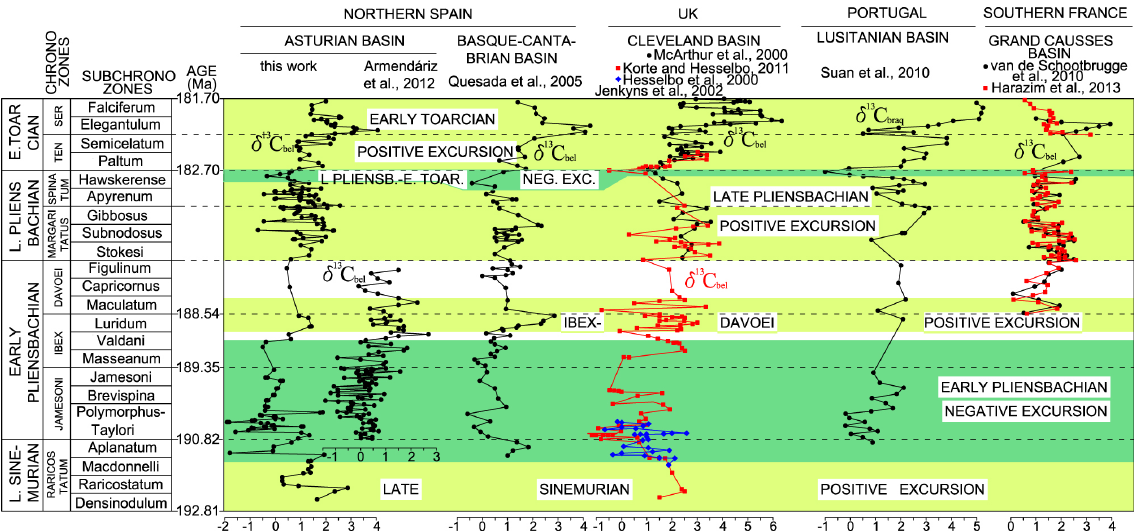
Figure 6. Correlation chart of the belemnite calcite-based δ 13 C sketched curves across Western Europe. The earliest isotopic event is the Late Sinemurian δ 13 C positive excursion, followed by the Early Pliensbachian negative excursion and the Ibex–Davoei positive peak. The Late Pliensbachian δ 13 C positive excursion is bounded by a δ 13 C negative peak, located around the Pliensbachian–Toarcian boundary. A sig- nificant δ 13 C positive excursion is recorded in the Early Toarcian. δ 13 C bel values in PDB. Chronozones abbreviations: TEN: Tenuicostatum. SER: Serpentinum. Ages (Ma) after Ogg and Hinnov